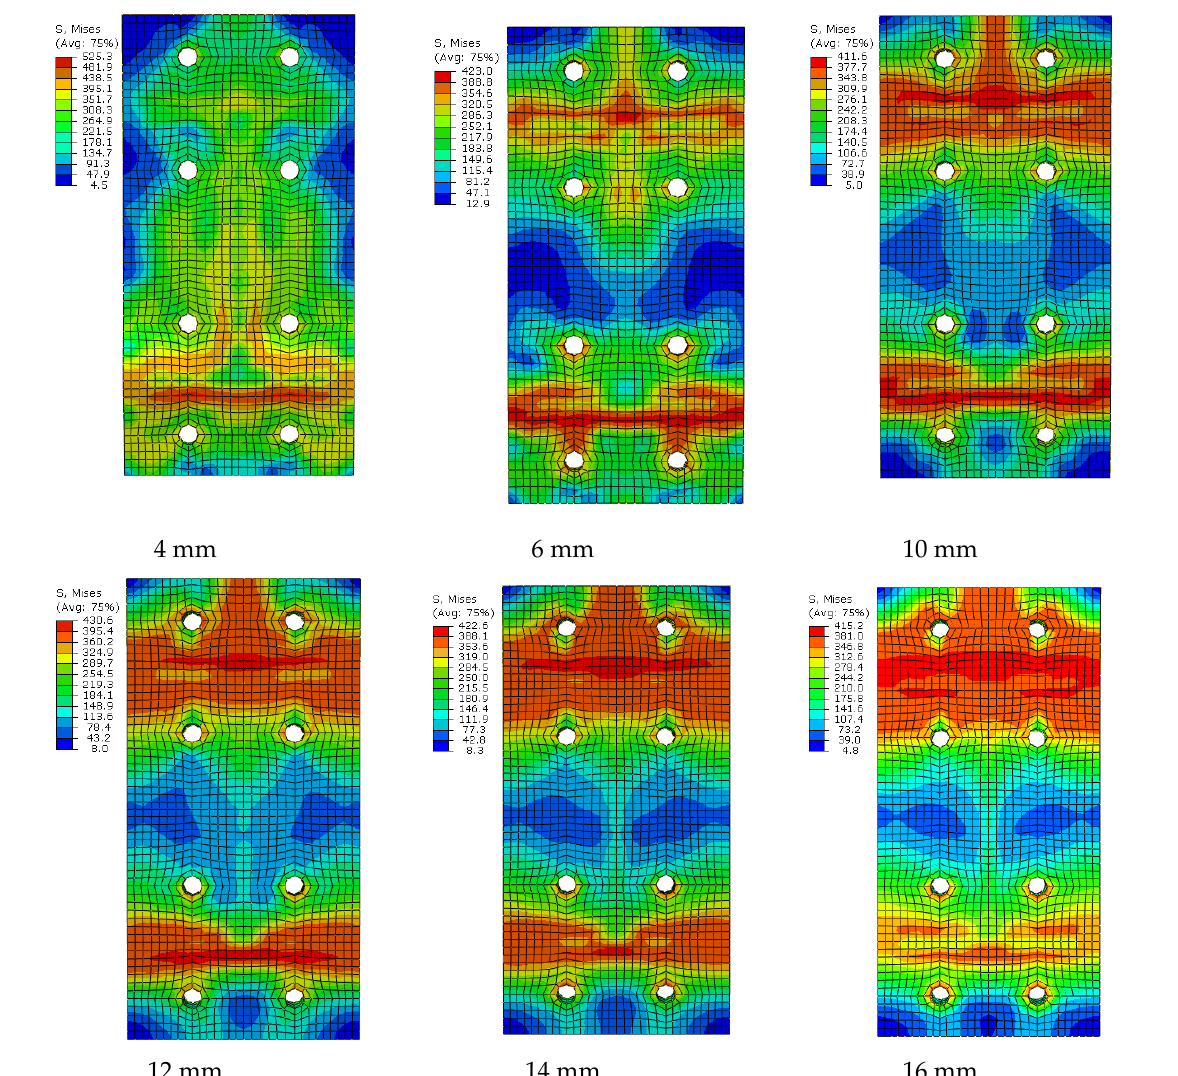
Figure 22. Stress distribution of the end-plate.